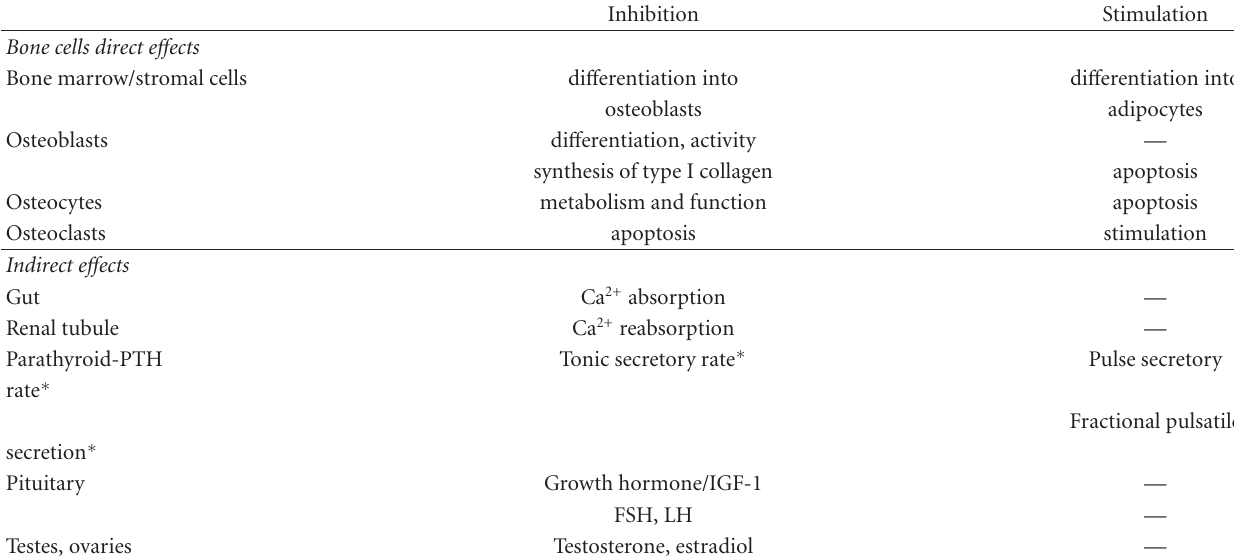
Table 2: The mechanisms of bone loss during long-term GCs